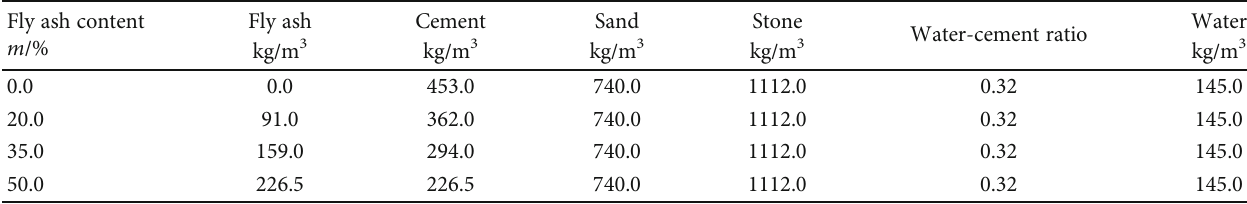
Table 2: Mix ratio of